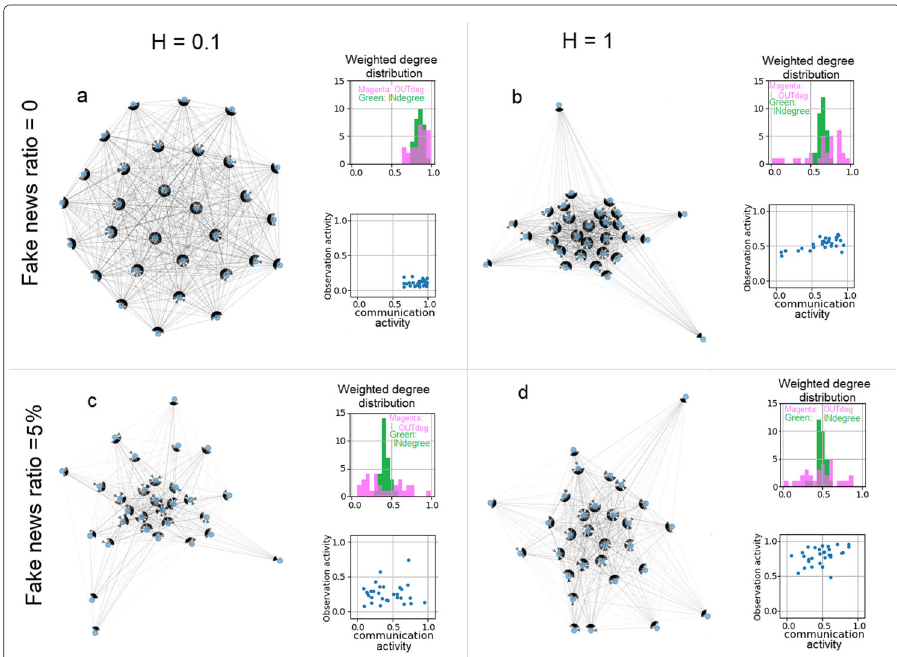
Fig. 3 Features of the optimal communication networks for different H and R FN values. The three pictures in all the four subfigures are the following: (i) the graphic representation of the optimal communication network, (ii) the weighted in and out degree distribution of the optimal communication network, and (iii), the observation activity values as a function of the communication activity values. In order to retrieve a more intuitive representation of the optimal communication network, we have omitted the edges with very small = 0.01). As it can be seen in the insets entitled “Weighted degree weights (the ones smaller than 0.3 N distribution”, the weighted in -degree values are very similar for all nodes, independently of H or the fake news ratio (green bars). However, exposure to fake news (bottom row, subfigures c and d ) results in smaller weighed in-degree values (the green bars are shifted towards smaller values). Furthermore, exposure to false information or high values of H (subfigures b and d ) calls forth “blurred” out -degree distribution (magenta color), marking the differentiation of agents regarding their role in spreading the information, which phenomenon can not be observed in subfigure a . Agents with zero or close-to-zero communication activity values are the peripheral nodes on the graphs who are connected to the rest of the group only via in-coming